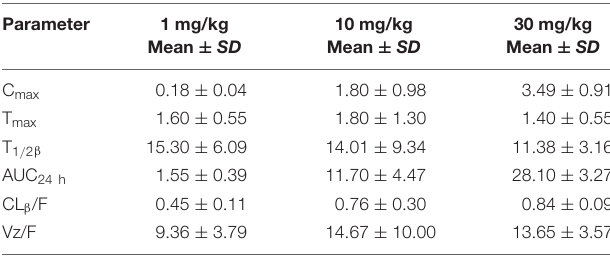
TABLE 1 | Pharmacokinetic parameters of danofloxacin in serum following oral administration to Salmonella typhimurium- infected rabbits ( n = 10/group). Parameter